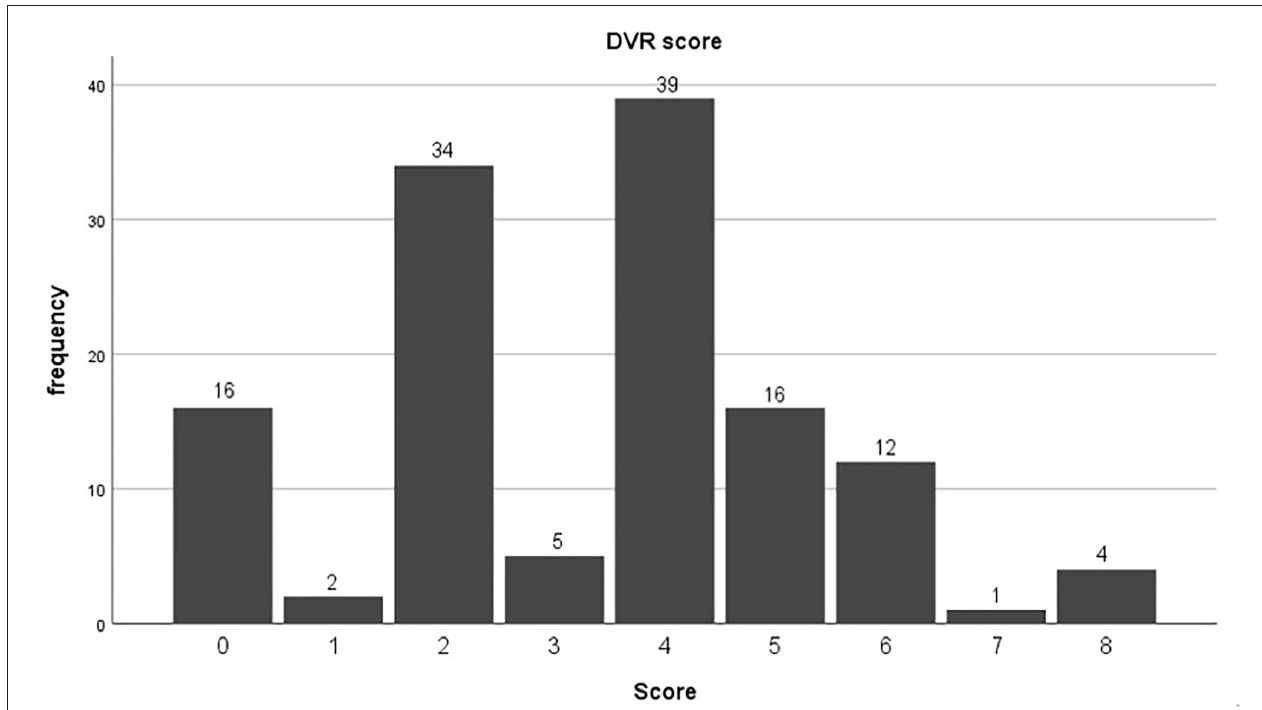
FIGURE 2 | Deep venous reflux